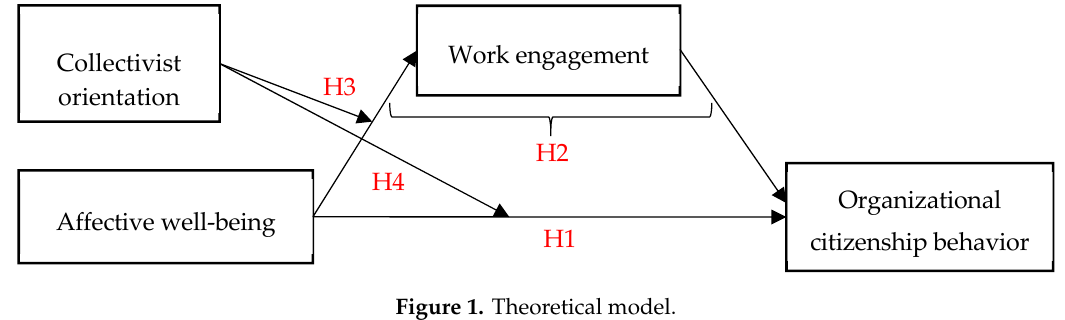
Figure 1. Theoretical model.